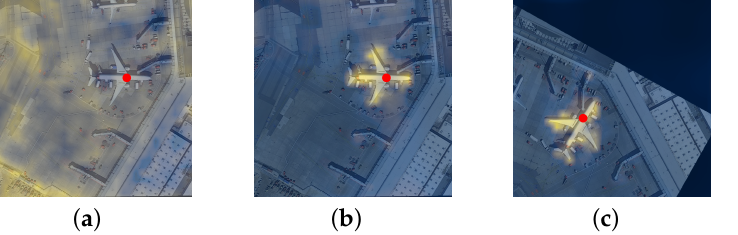
Figure 2. The relative importance of a single token (red point) with respect to the other tokens in the image is visualized. The shade of yellow color represents the degree of importance. ( a ) represents the beginning of the transformer’s backbone training. ( b ) represents the state after the transformer’s backbone is trained. ( c ) shows the object at different angles in the